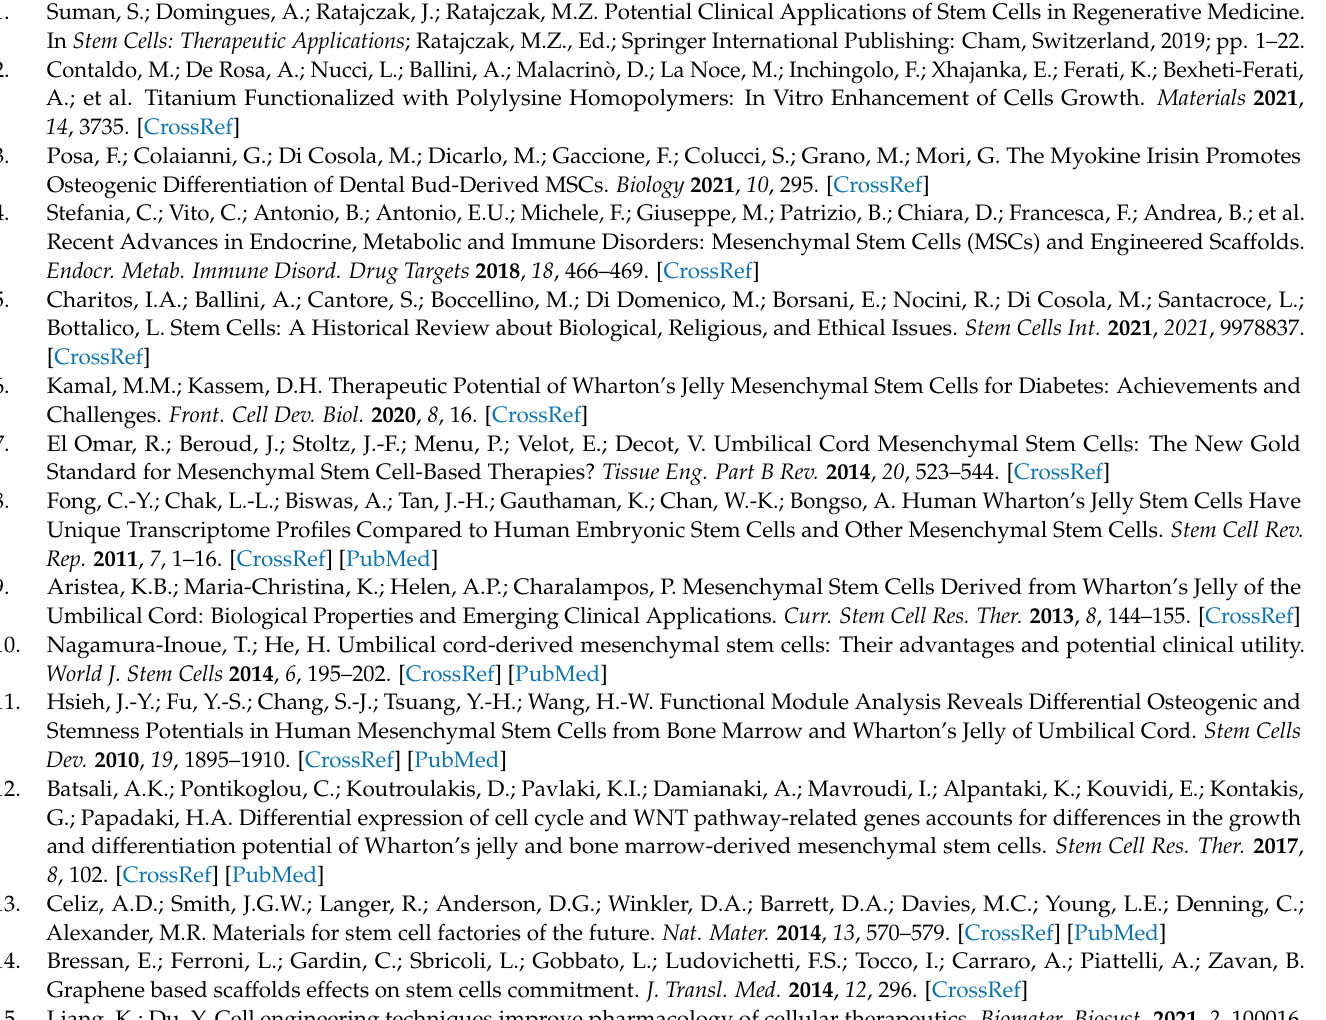
bar represents 200 µ m, Figure S4: Alizarin red-staining of WJ-MSCs on m-GO film before and after conjugate with peptide sequence (PepS1, PepS2, PepS3 and PepS4) after 14 days of basal medium (BM) incubation. All scale bars represent 200 µ